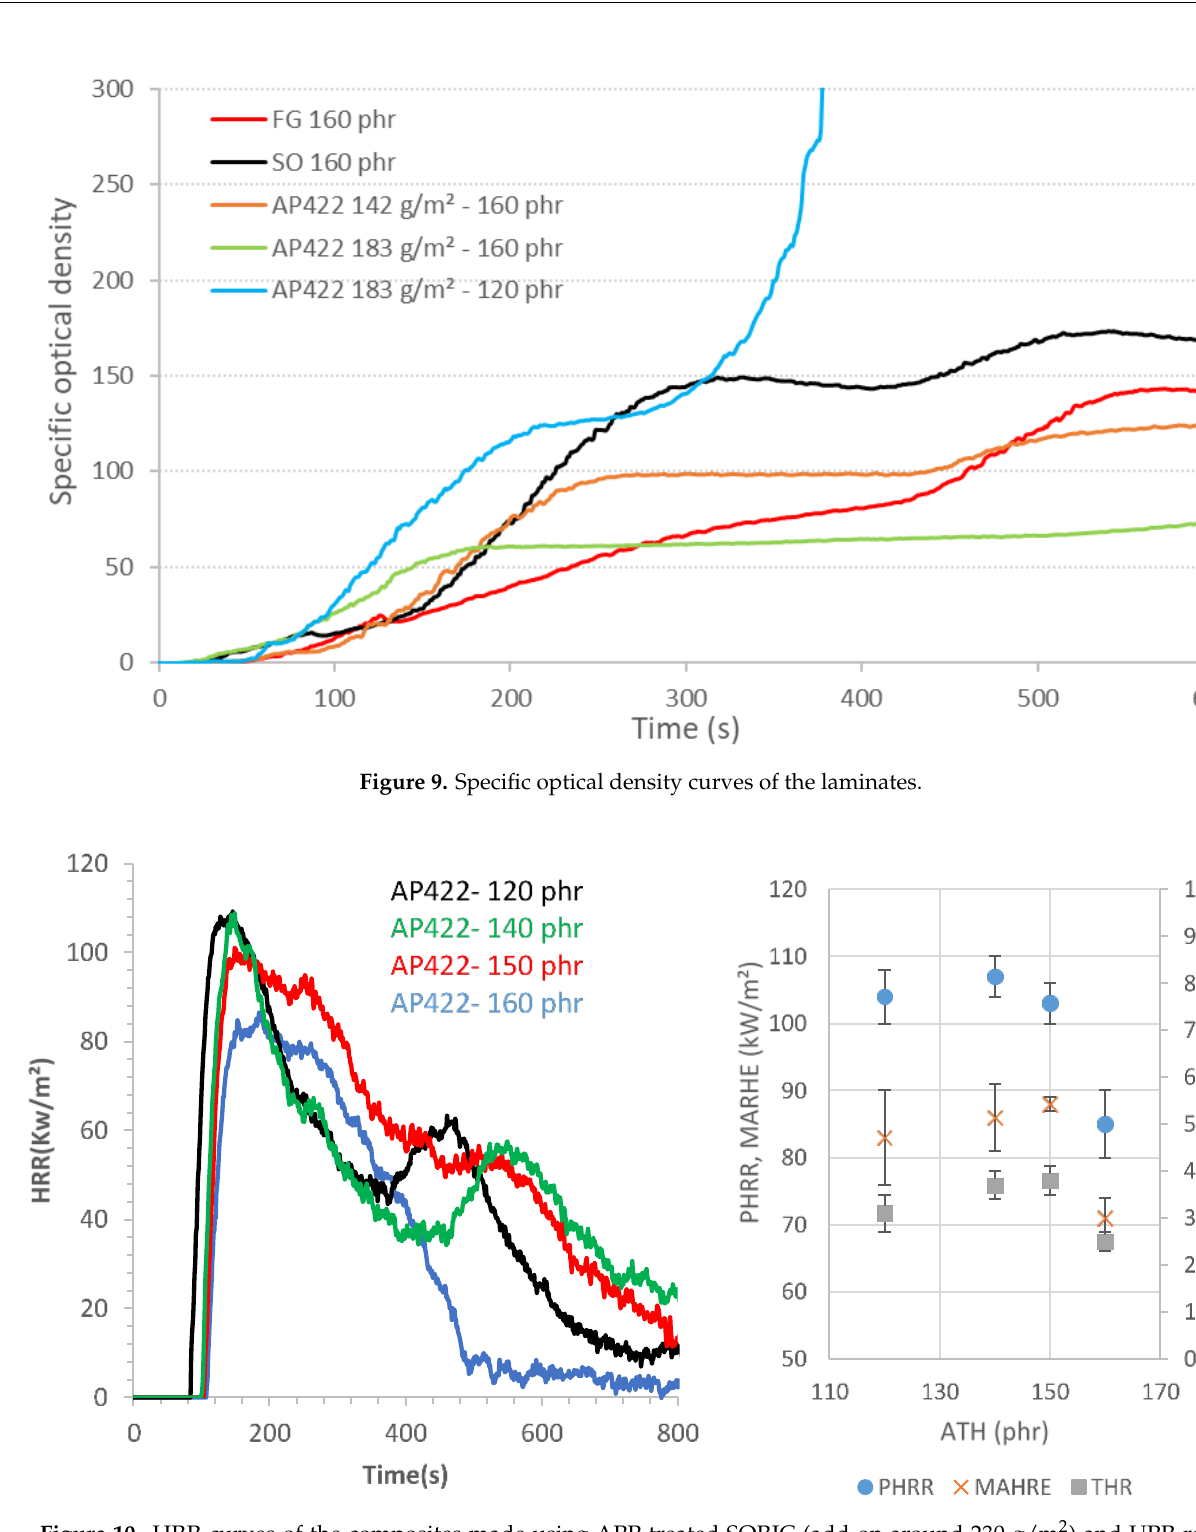
Figure 10. HRR curves of the composites made using APP-treated SORIC (add-on around 230 g/m 2 ) and UPR resins containing different ATH loadings, and evolution of some of the cone parameters versus the ATH loading.